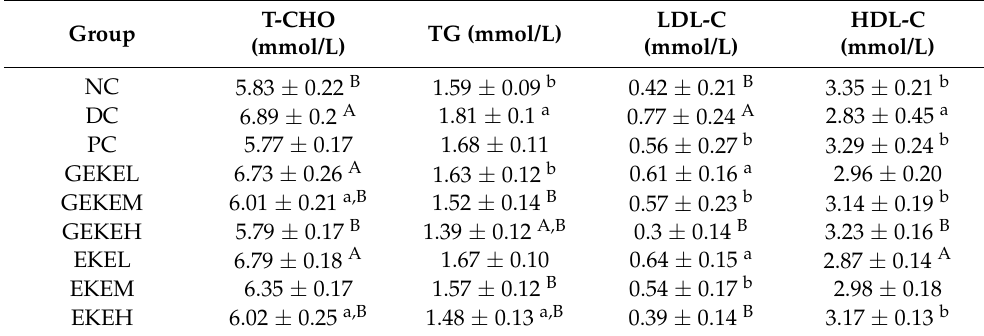
Table 6. Serum lipid levels in each group of mice (x ± s, n =